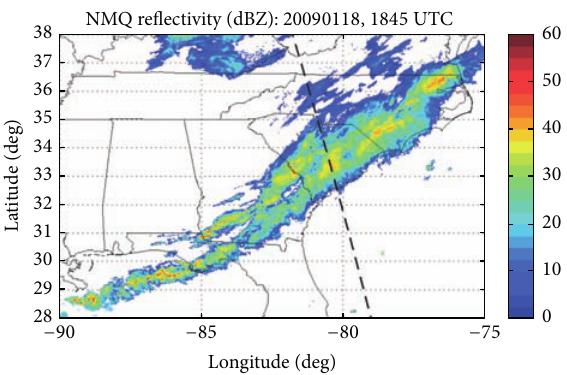
Figure 1: The CloudSat track has been overlaid with the NMQ composite reflectivity from 18 January, 2009 at 1845 UTC.